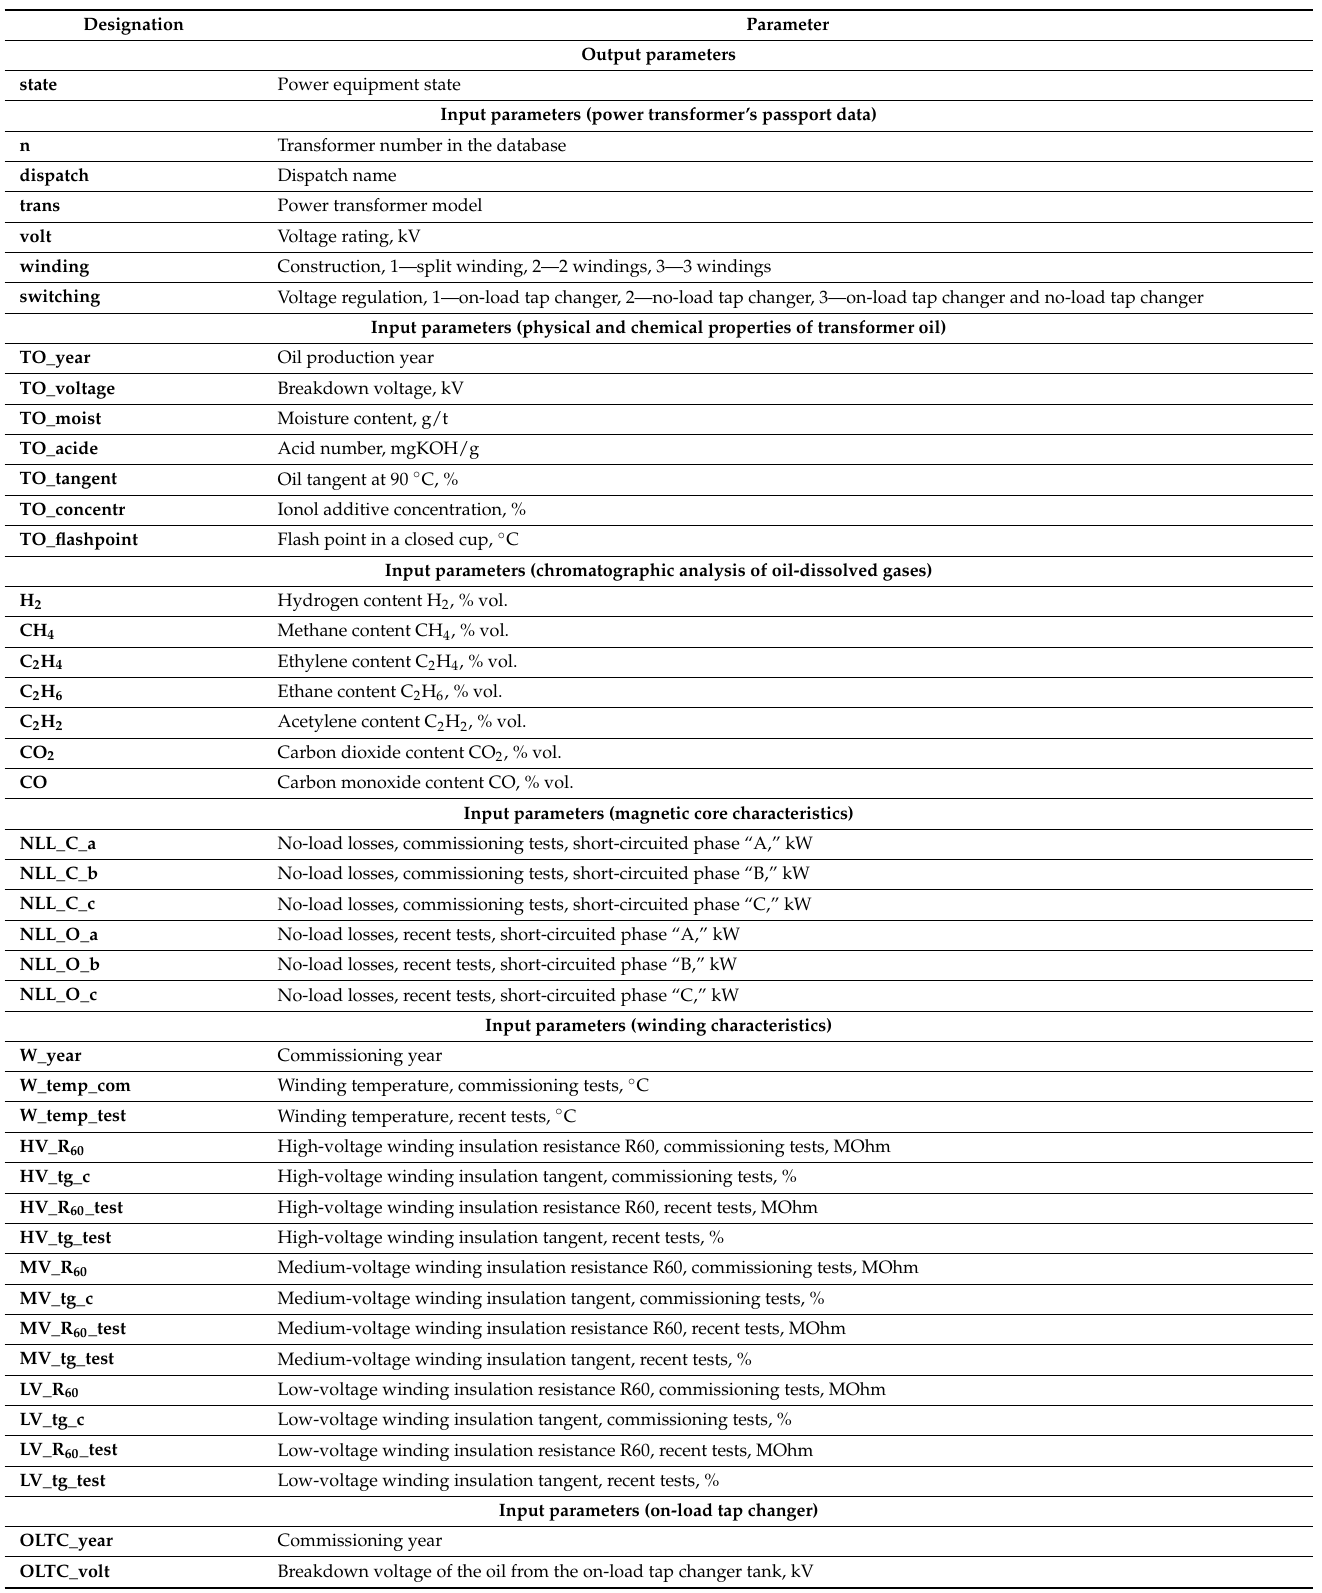
Table 1. Transformer